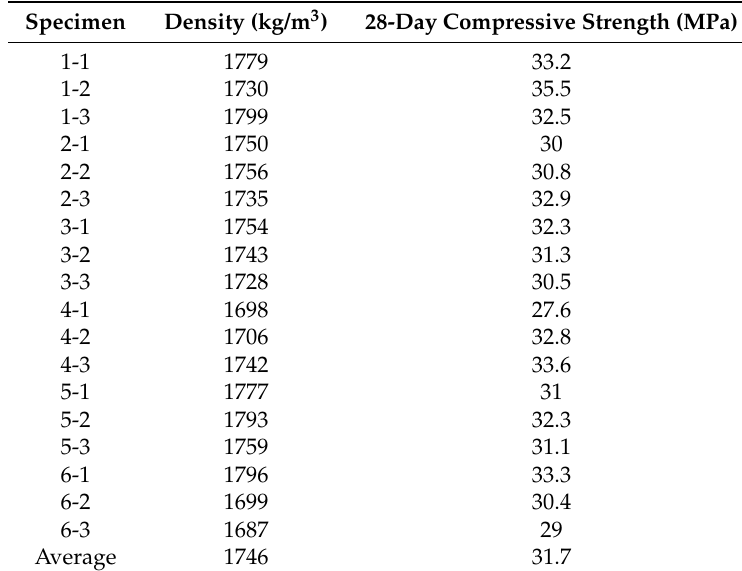
Table 2. Density and compressive strength of bricks.